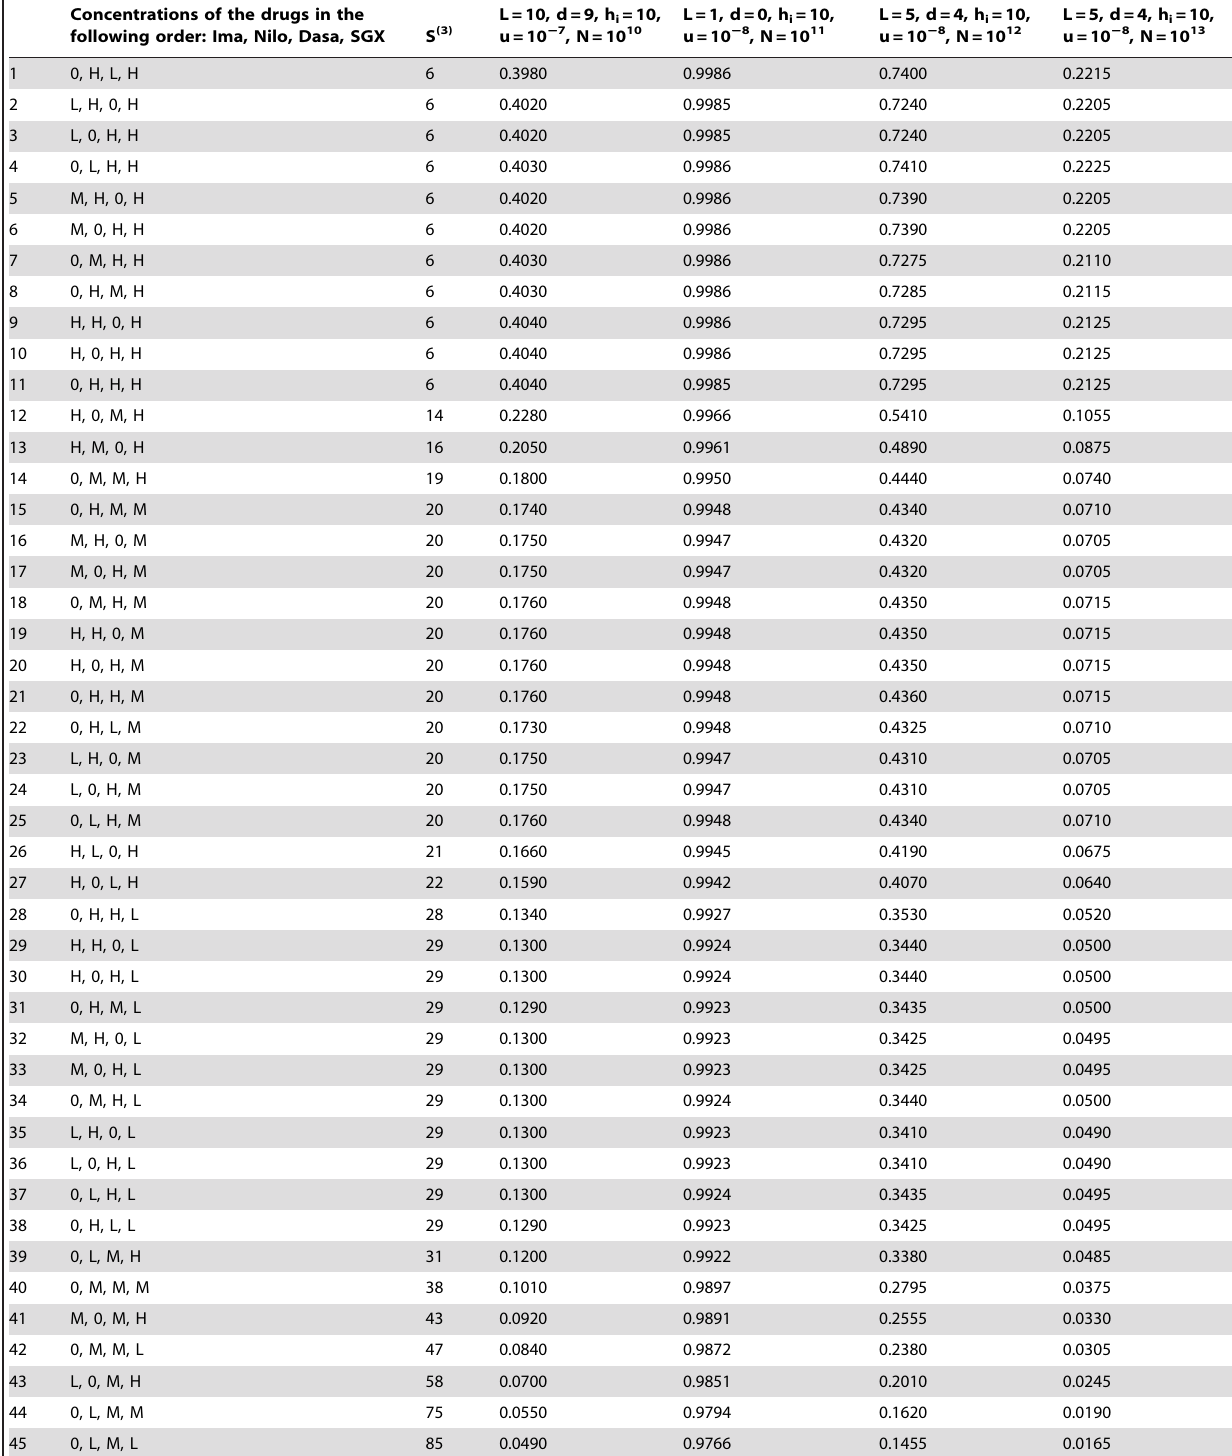
Concentrations of the drugs in the following order: Ima, Nilo, Dasa,